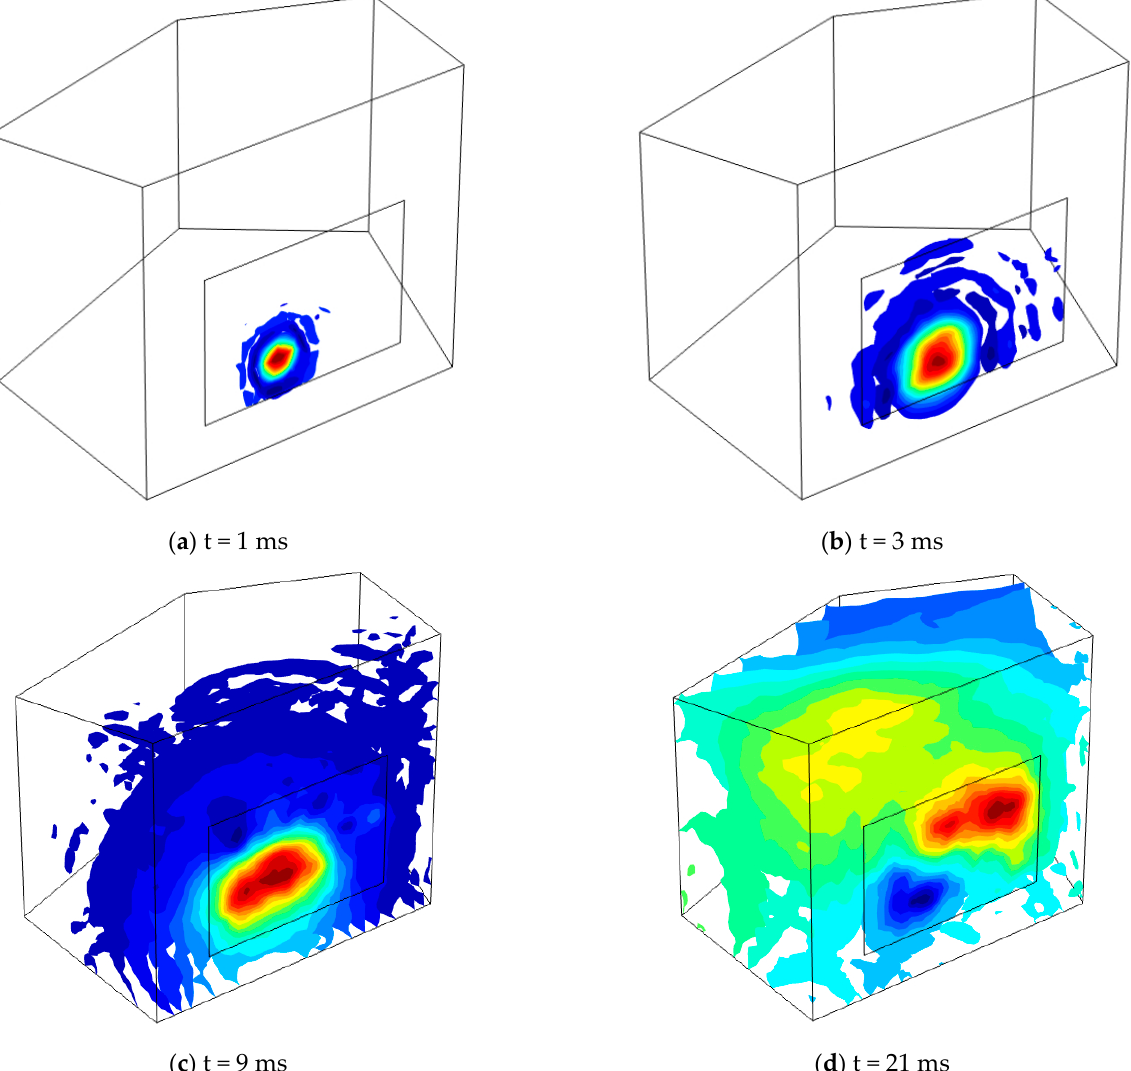
Figure 3. The aspect of sound pressure propagation: Time series of the propagating sound pressure level after the impact point (impact hammer) was shocked. The vibration was converted into sound pressure and the sound were scattered gradually as propagation whole room. The sound pressure level also lessens with the lapse of time.